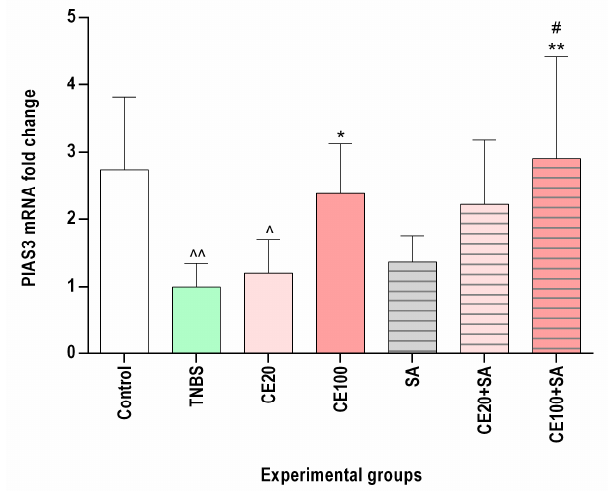
Figure 3. The impact of cornelian cherry iridoid-polyphenolic extract on the PIAS3 gene expression in the colon tissues in experimental groups. Control—control group; TNBS—group receiving only TNBS; CE20, CE100—groups receiving, respectively, 20 or 100 mg/kg cornelian cherry extract and TNBS; SA—group receiving 100 mg/kg sulfasalazine and TNBS; CE20+SA, CE100+SA—groups receiving, respectively, 20 or 100 mg/kg cornelian cherry extract and 100 mg/kg sulfasalazine and TNBS. Relative expression levels were analyzed by qPCR. Data are presented as mean values ± SD. Analyses were performed using the one-way ANOVA and Tukey’s post hoc test. Differences ˆ p < 0.05, ˆˆ p < 0.01 vs. control group; * p < 0.05, ** p < 0.01 vs. TNBS group; # p < 0.05, vs. sulfasalazine group were deemed statistically significant.